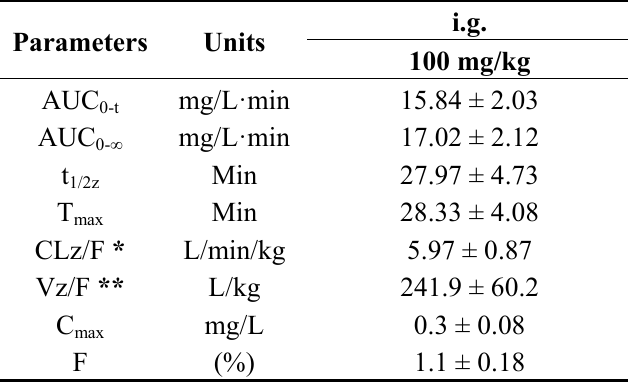
Table 2. Pharmacokinetic parameters for wogonin in rats after intragastric (i.g.) administration of 100 mg/kg wogonin (mean ± SD, n =